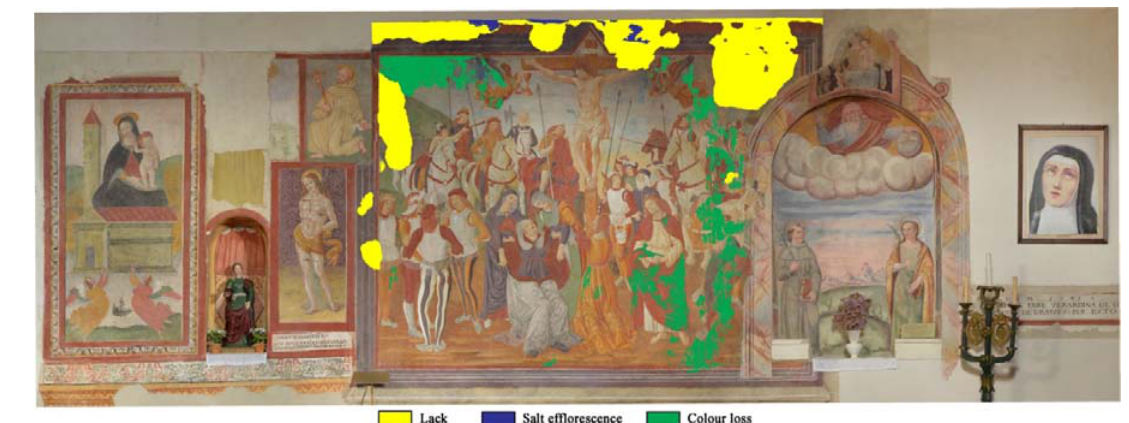
Figure 4. Example of expeditious documentation by SeVAMH survey form.